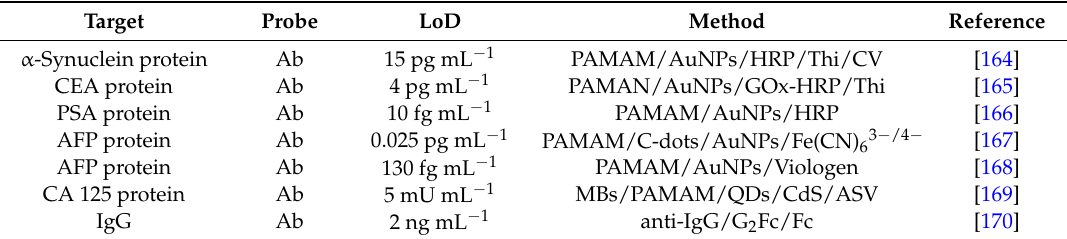
Table 10. Figures of merit of selected immunosensors using